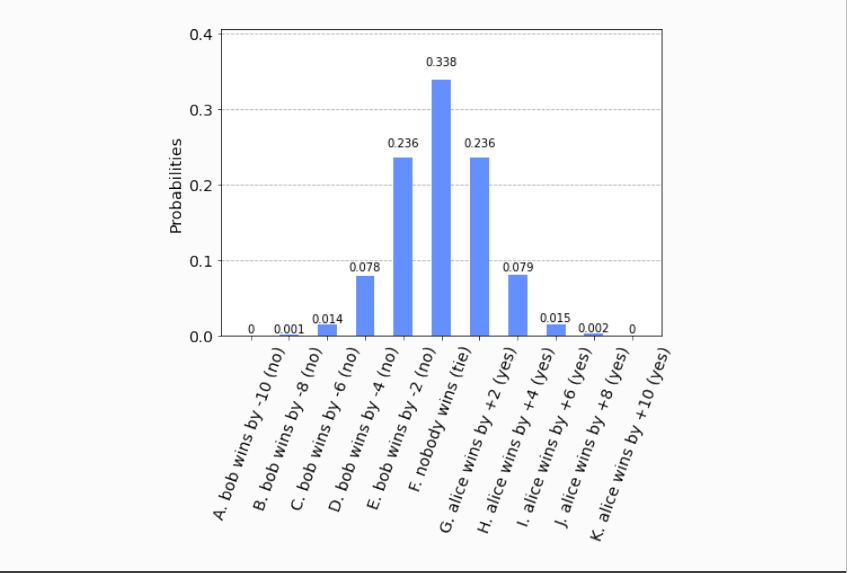
Figure 28. The possible outcomes when n A = n B = 6, r A = r B = 0.5, and n I =